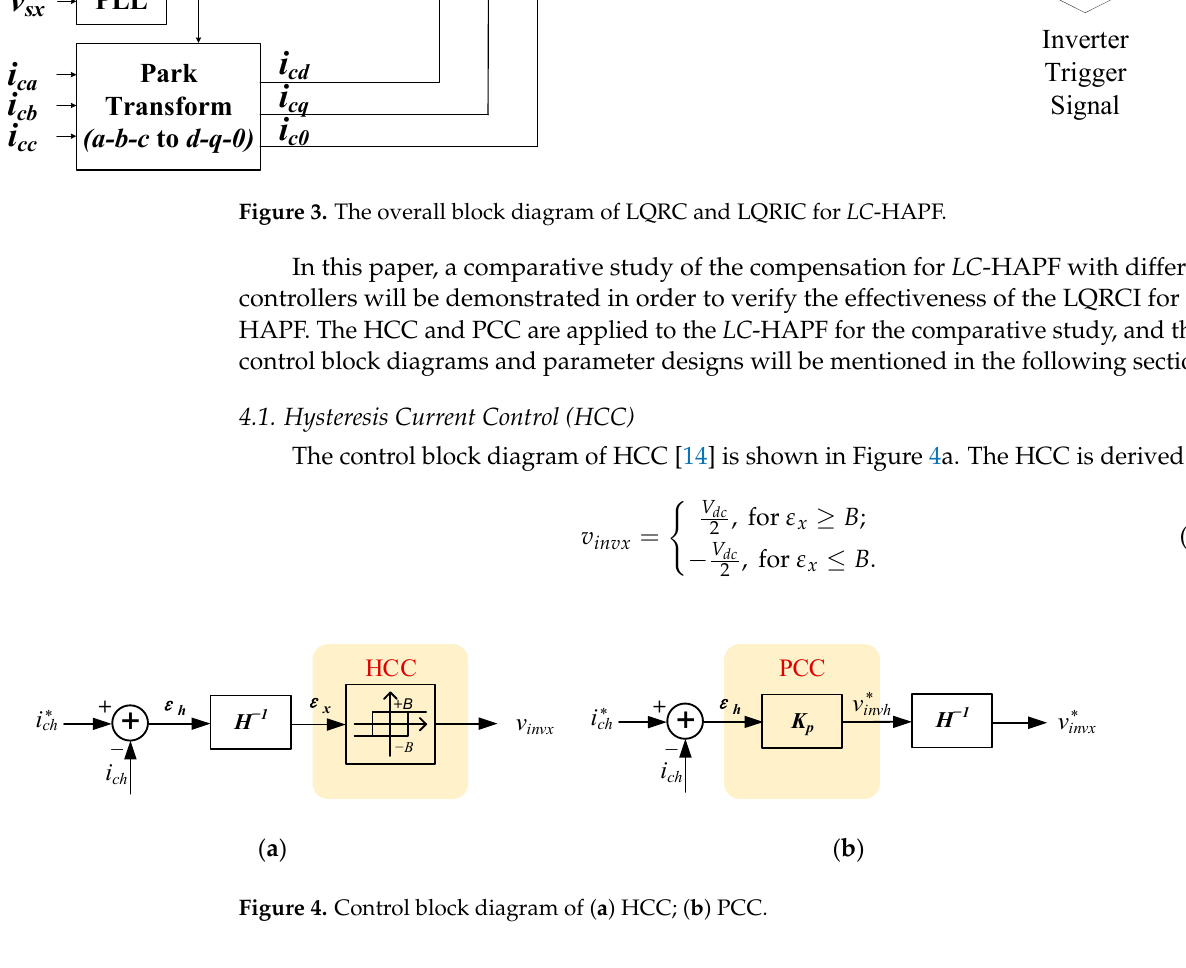
Figure 3. The overall block diagram of LQRC and LQRIC for LC -HAPF.